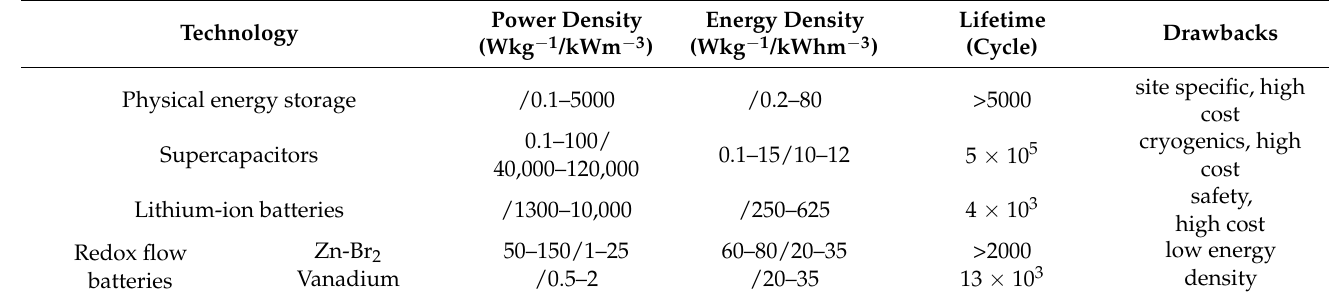
Table 1. The performance of some battery energy storage